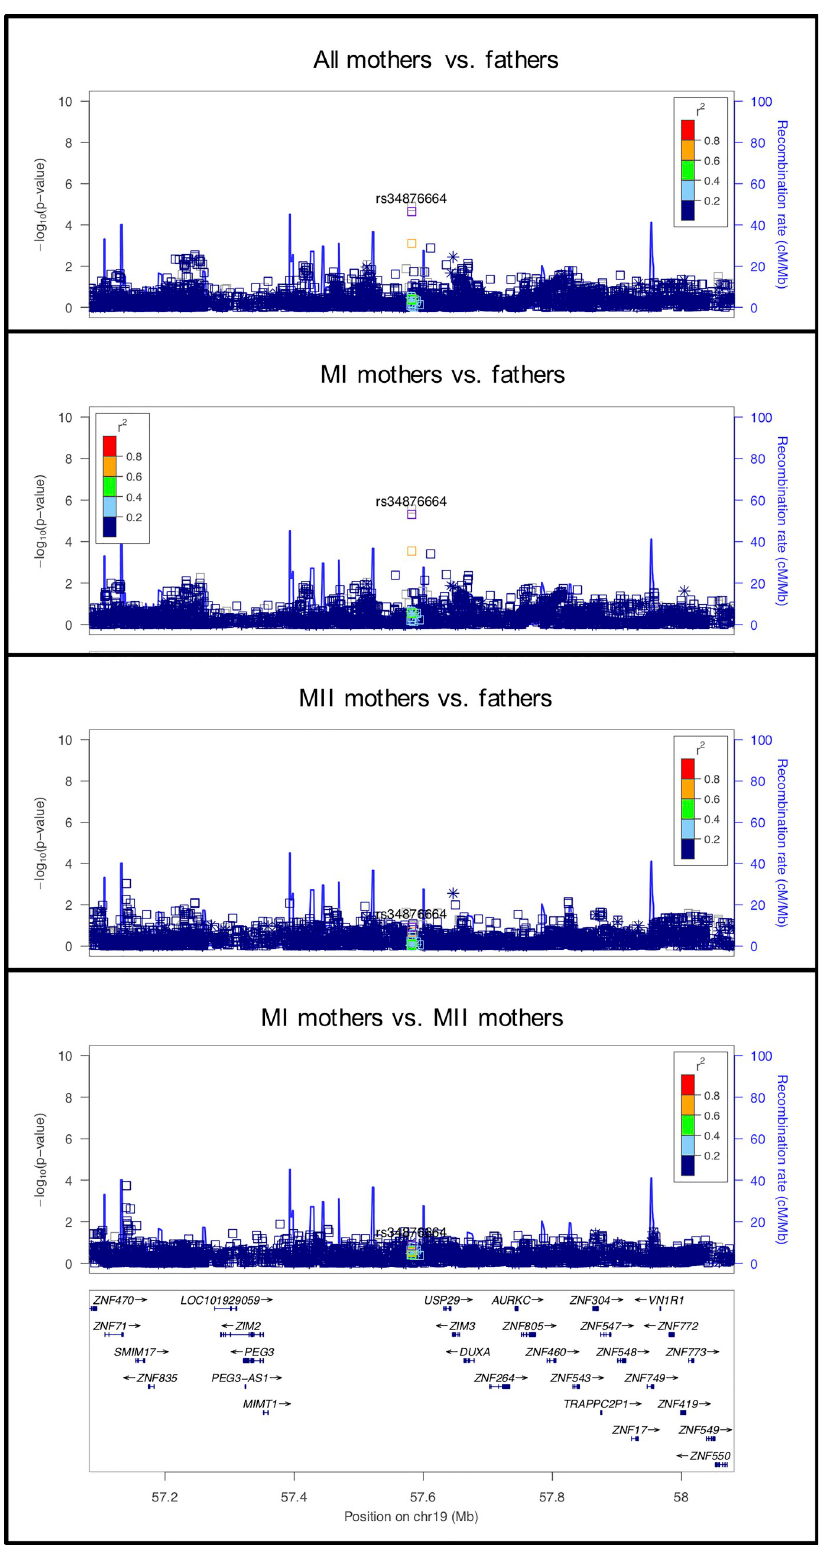
Fig 8. LocusZoom plot for AURKC